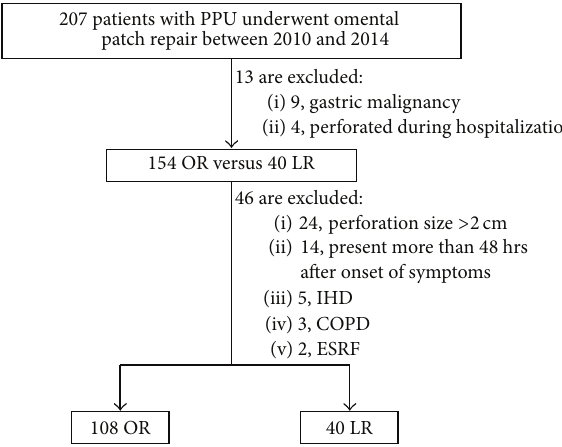
Figure 1: Flowchart of patient selection, inclusion, and exclusion criteria for the study. PPU: perforated peptic ulcer; IHD: ischemic heart disease; COPD: chronic obstructive pulmonary disease; ESRF: end stage renal failure. OR: open repair; LR: laparoscopic